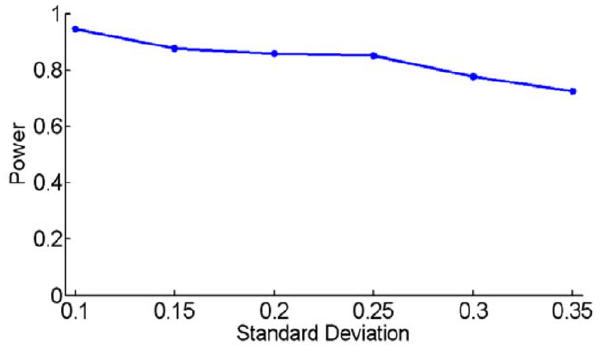
Figure 7. Power curve for TAGCNA for simulated datasets containing two SCEs. The normal tissue contamination in the datasets is generated under a Gaussian distribution with mean 0.6 and varying standard deviation from 0.1 to 0.35. The power is averaged over 100 simulation replications.